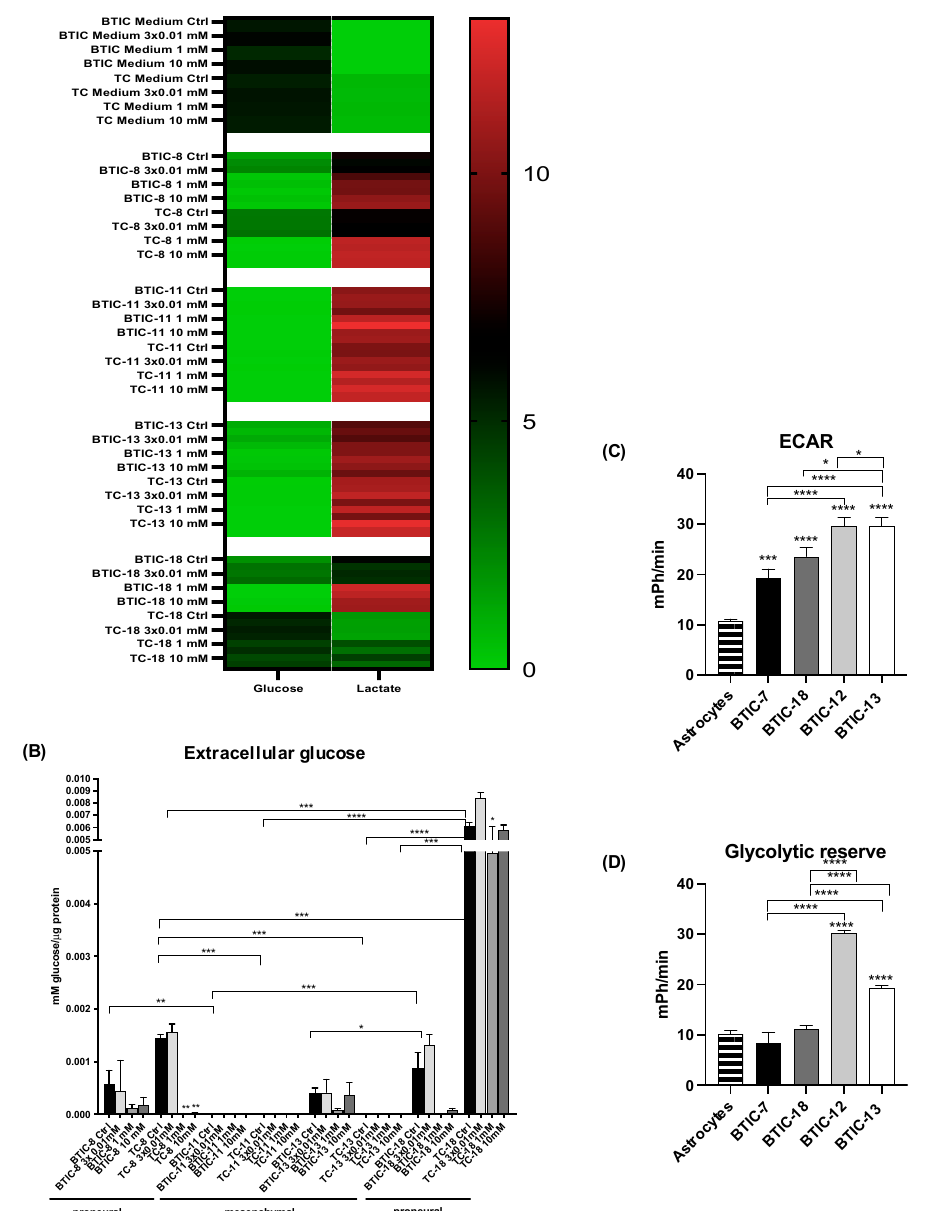
Figure 4. Metabolite expression and glycolytic activity. ( A ) We measured extracellular glucose and lactate after 48 h in BTIC- and TC-8, -11, -13, and -18 with or without treatment with 0.01 mM met- formin three times per day (tid), 1 mM metformin and 10 mM metformin using GC/MS. ( B ) Glucose values are also depicted per µg protein. Asterisks directly above the bar indicate significance as compared to the respective control. Proneural BTIC-8 and -18 consume less glucose than mesenchy- mal BTIC-11. Even more pronounced, TC-8 and -18 consume far less glucose than mesenchymal TC-11 and -13. ( C ) The extracellular acidification rate and ( D ) glycolytic reserve was significantly higher in mesenchymal BTIC-12 and mesenchymal BTIC-13 than in proneural BTIC-7 or proneural BTIC-18 in Seahorse assays. Asterisks directly above the bar indicate significance as compared to astrocytes. All assays were performed in triplicate. Significant results are only depicted for valid comparisons, i.e., comparing proneural and mesenchymal BTICs or proneural and mesenchymal TCs, or the corresponding BTIC and TC pair. Asterisks indicate * p < 0.05, ** p < 0.01, *** p < 0.001, and **** p <